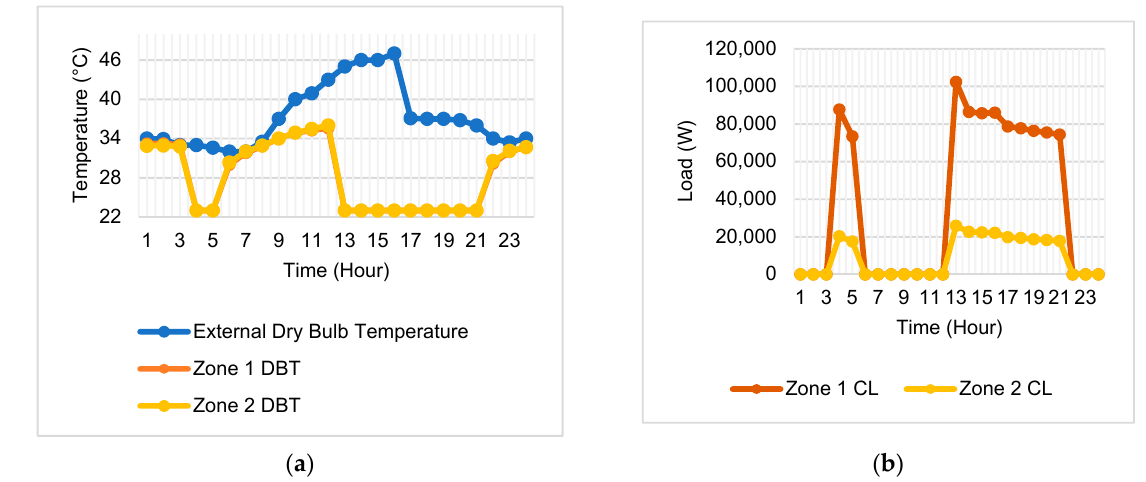
Figure 12. ( a ) External dry bulb temperature versus internal dry bulb temperature in summer in Hudhayfah mosque during day 179; ( b ) cooling load (CL) during summer in Hudhayfah mosque by the hour during day 179.